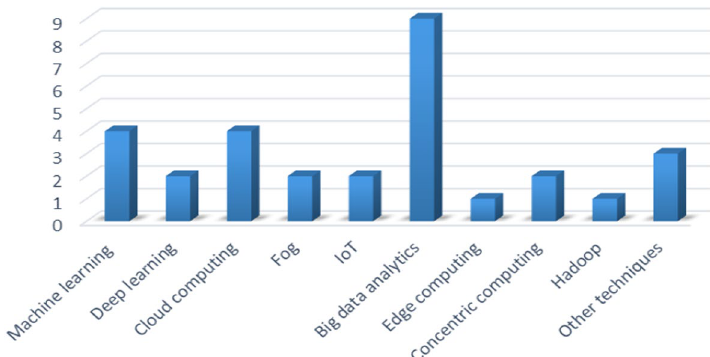
Fig.2 Chart based on the techniques used in the big data applications